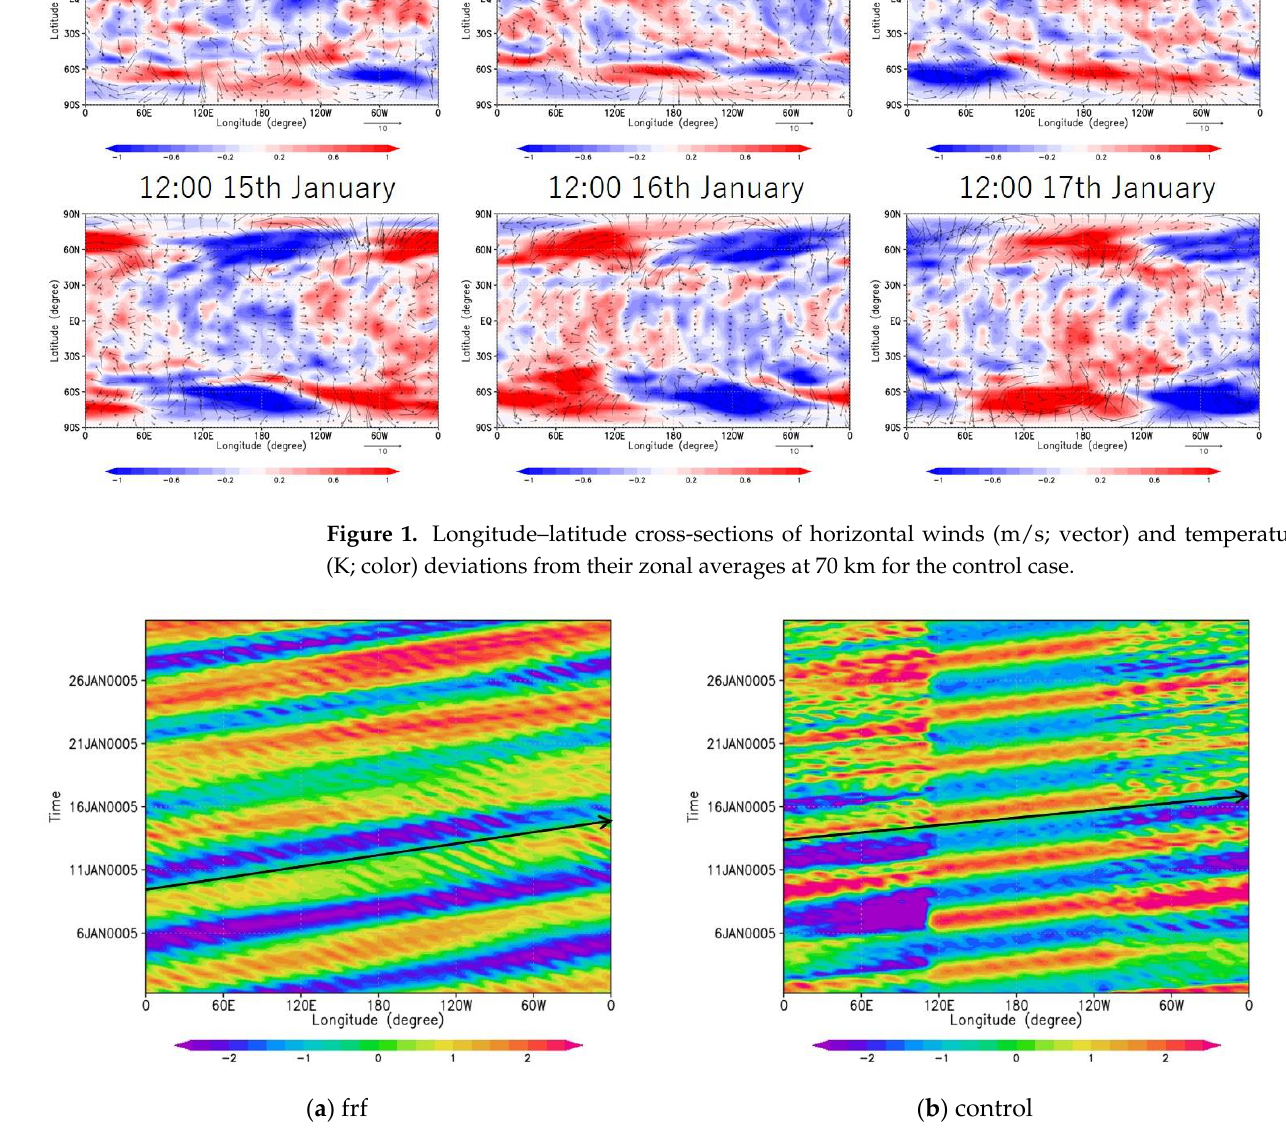
Figure 1. Longitude – latitude cross-sections of horizontal winds (m/s; vector) and temperature (K; color) deviations from their zonal averages at 70 km for the control case.